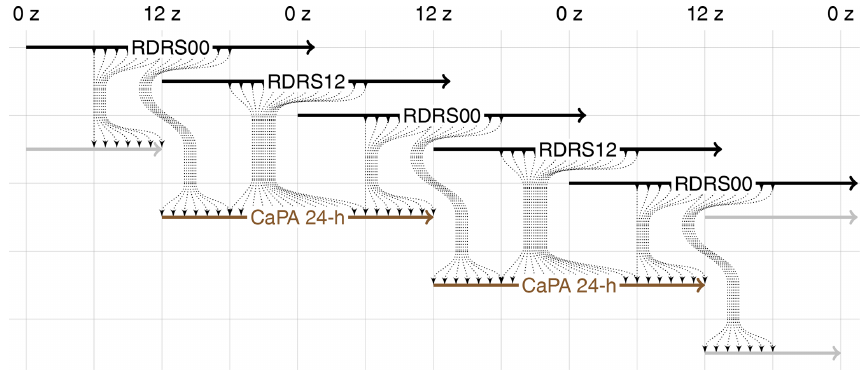
Figure 3. Flowchart illustrating the approach to build 24h accumulation and produce 24h precipitation analysis at 12:00UTC based on 6 to 18h lead time RDRS outputs from integrations started at 00:00 and